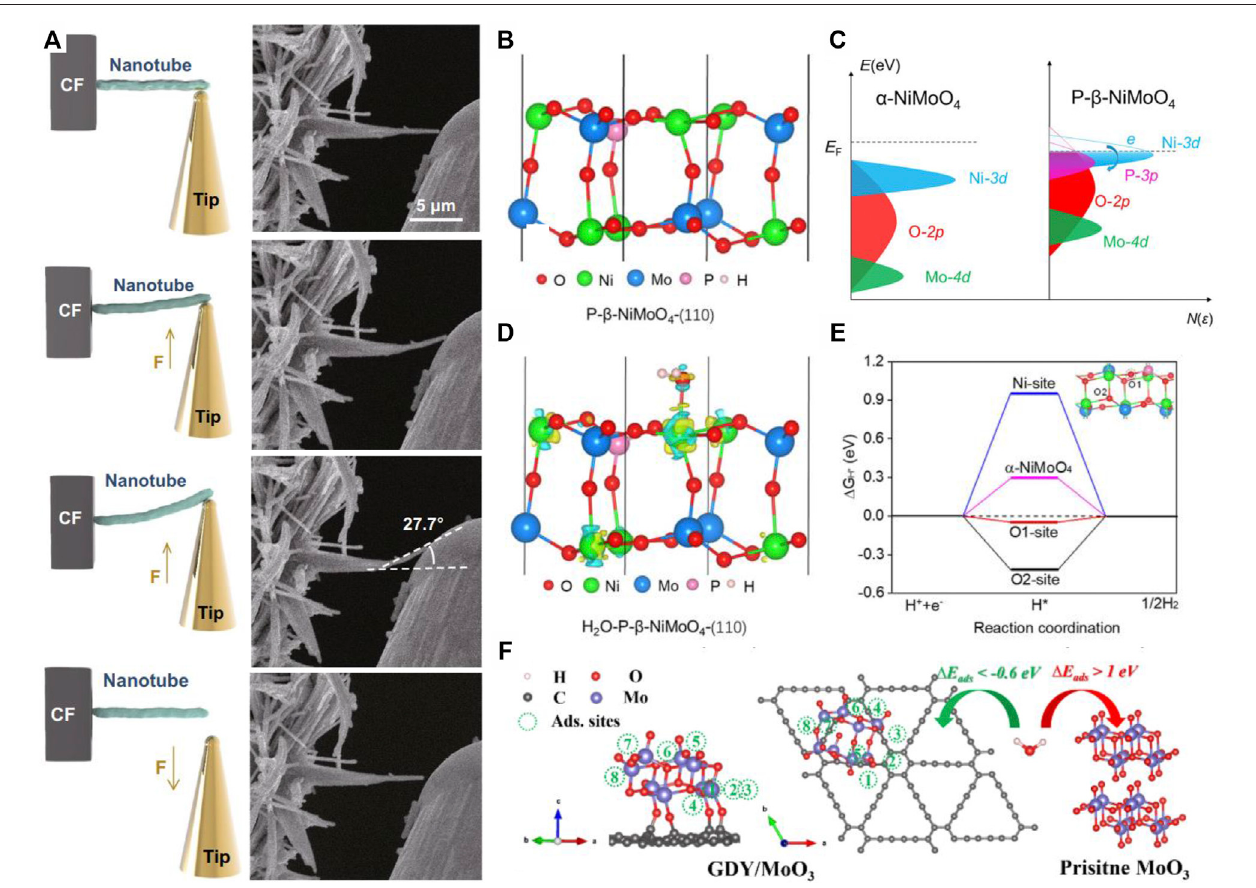
FIGURE 2 | (A) In situ bending deformation and restoration measurement by SEM probe, reproduced with permission from Zhang et al. (2020c). (B) Optimized structure of P- β -NiMoO 4 -(110). (C) Active electric states in different phases of NiMoO 4 . (D) Charge density differences of H 2 O adsorbed on Ni sites in P- β -NiMoO 4 . (E) Hydrogen adsorption free energy ( Δ GH*) in different exposed atoms in P- β -NiMoO 4 , reproduced with permission from Wang et al. (2021c). (F) H 2 O adsorption sites on GDY/MoO 3 and H 2 O adsorption on pristine MoO 3 and GDY/MoO 3 , reproduced with permission from Yao et al.